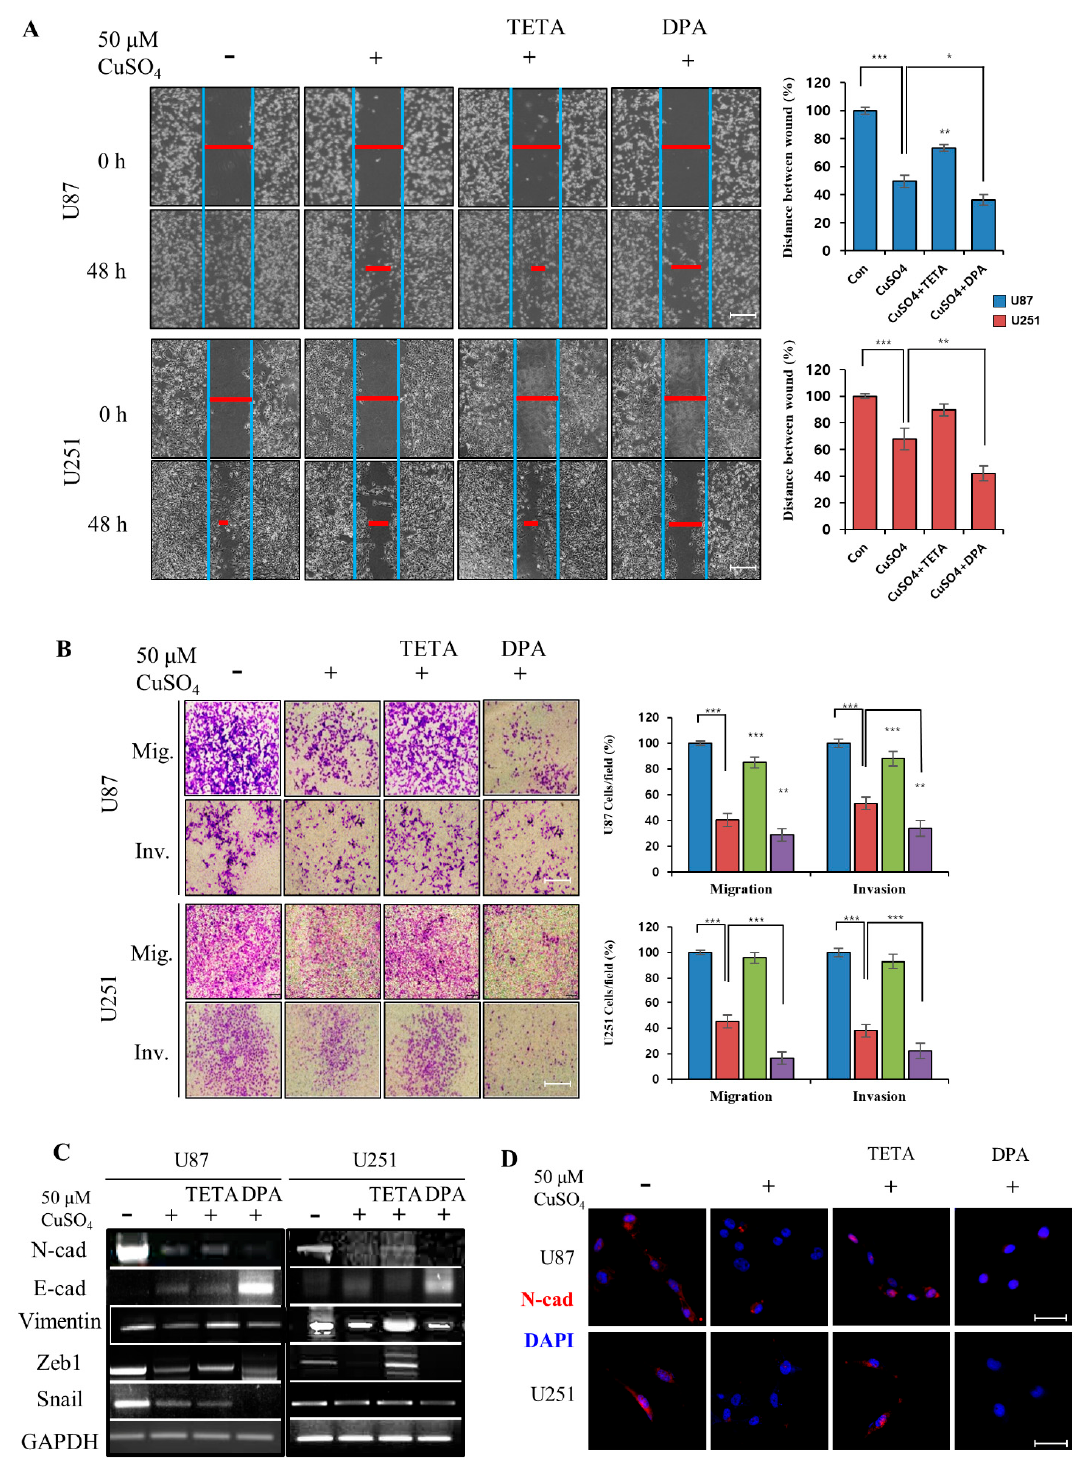
Figure 3. ( A ) Wound healing capacity of U87 and U251 cells treated with 50 µ M of CuSO 4 and 100 µ M chelators. Scale bars: 200 µ m. ( B ) The migration/invasion assay indicating that treatment of CuSO 4 and DPA was highly effective in GBM cell migration and invasion in both cell lines. Scale bars: 200 µ m. ( C ) The expression of EMT regulators and transcription factors in GBM cells using RT-PCR. ( D ) Immunofluorescent analysis of N-cadherin, after treatment with CuSO 4 with chelators in GBM cells. Scale bars: 100 µ m. Data represent mean ± SD of three independent experiments using two-tailed t -test. * p < 0.05, ** p < 0.01, *** p <